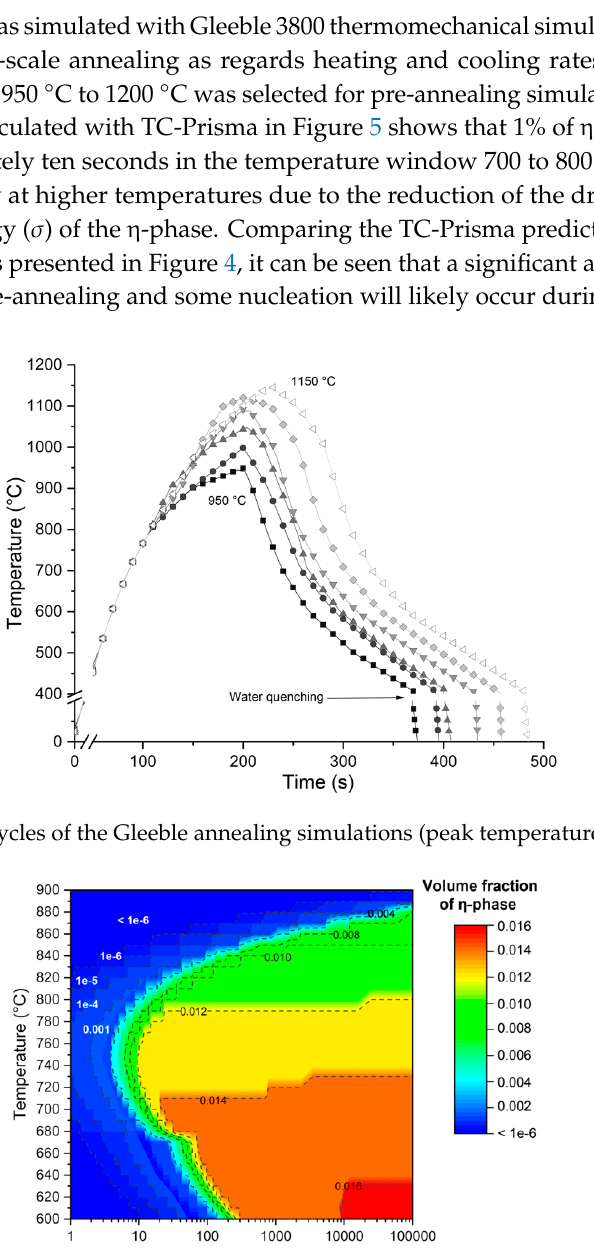
Figure 5. Isothermal precipitation diagram of η -phase in the trial High-Nb-SS steel.